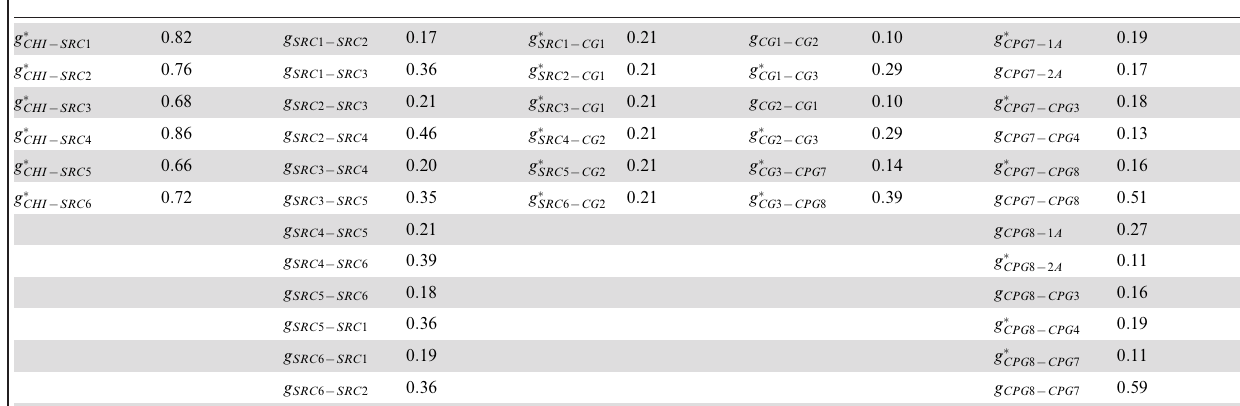
Table 3. Maximal conductances of chemical